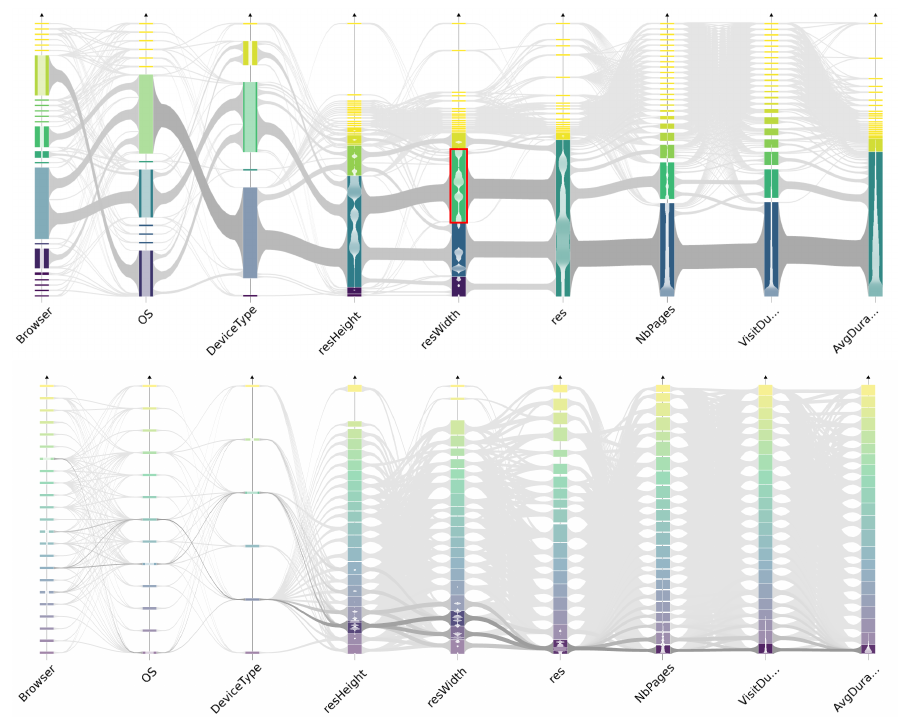
Figure 3. Both implemented visual encodings for the same abstraction ( k = 30). On top, the distribution encoding ; on the bottom, the interval encoding . Surrounded in red: the inner-cluster smoothed histogram view.